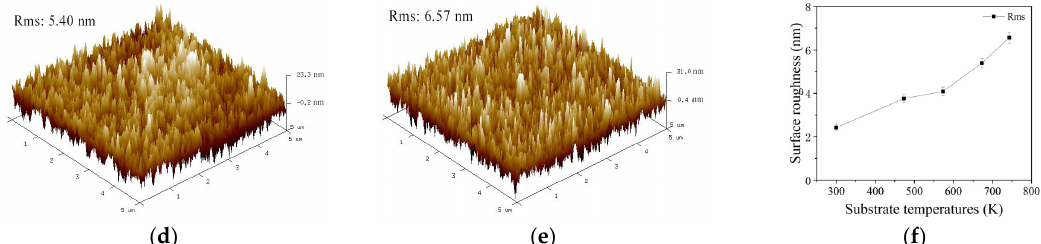
Figure 4. Surface atomic force microscope (AFM) images of WO 3 thin films deposited at different substrate temperatures ( a ) 300 K, ( b ) 473 K, ( c ) 573 K, ( d ) 673 K, ( e ) 743 K and ( f ) R a curve.